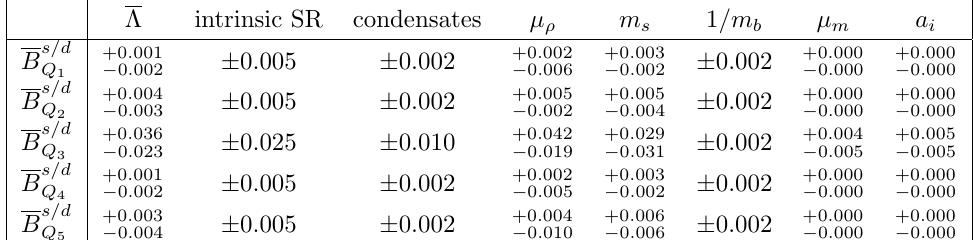
Table 3 . Individual errors for the ratio of Bag parameters in the B s and B d